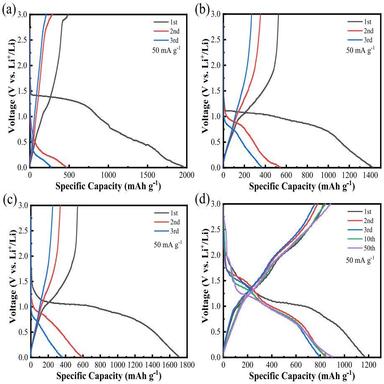
Charge-discharge profiles at 50 mA g− 1 for (a)Cu-IM, (b)Co-MOF, (c)Cu-IM/Co-MOF, (d)Cu-IM/Co-MOF 250.